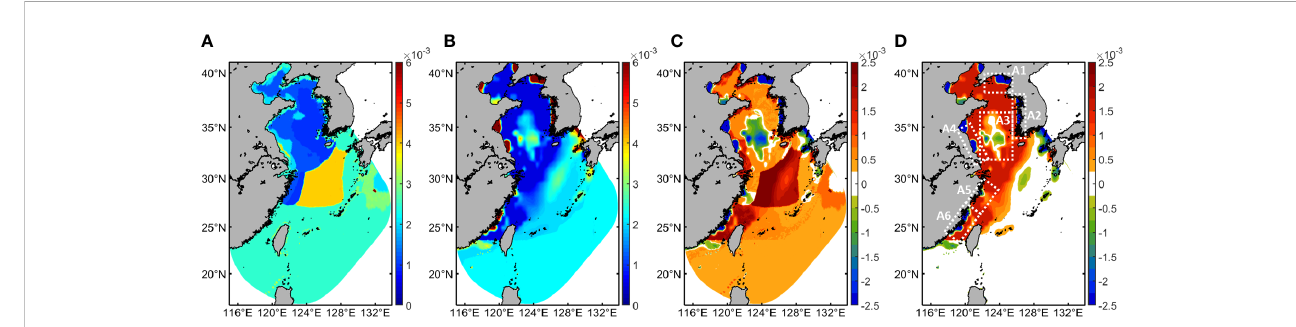
FIGURE 2 (A, B) Spatial distributions of BFCs of EXP 2 and EXP 3, respectively. (C) Differences between the BFCs of EXP 2 and those of EXP 3 (BFC EXP2 – BFC EXP3 ). (D) Differences between the BFCs of EXP 1 and those of EXP 3 (BFC EXP1 – BFC EXP3 ). White dashed boxes mark the areas of the Korea Bay (A1), the Jianghua Bay (A2), the middle South Yellow Sea (A3), and the eastern coasts of Jiangsu (A4), Zhejiang (A5) and Fujian provinces